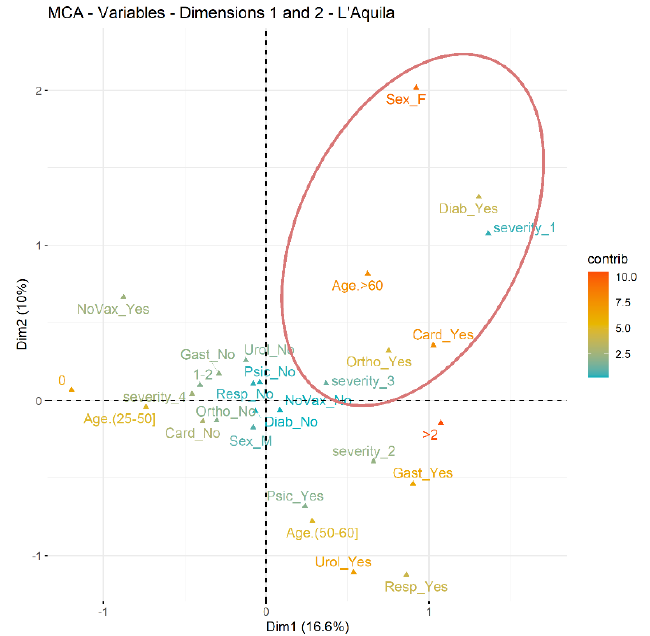
Figure 1. L’Aquila Prison.